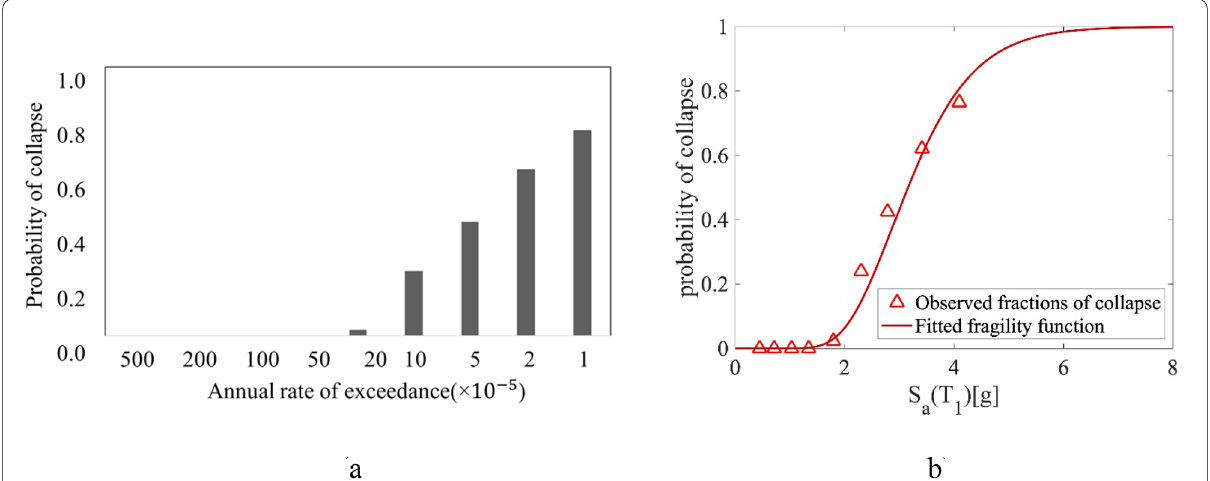
Fig. 15 Fragility function development. a Collapse rates for different hazard levels for model SPR-M. b Log-normal fitted function to observed collapse fractions.